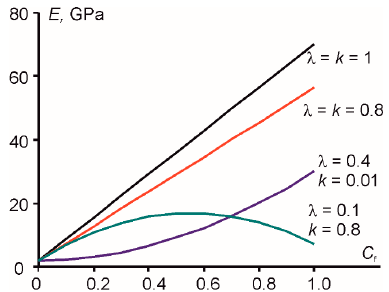
Figure 1. Elastic modulus of the polymer nanocomposites predicted by property prediction model and Equation (10) for di ff erent model parameters (indicated next to the curves, elastic modulus of the filler E f = 70 GPa, elastic modulus of the matrix E m = 2